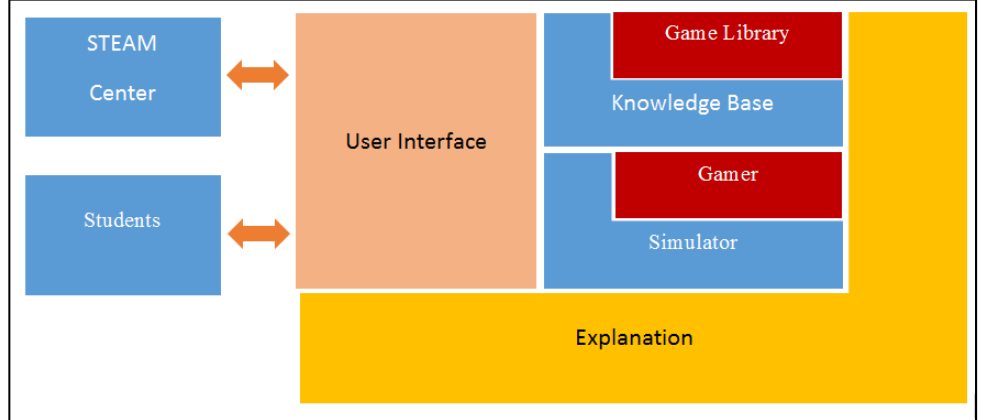
Figure 8. ViSMod Architecture.